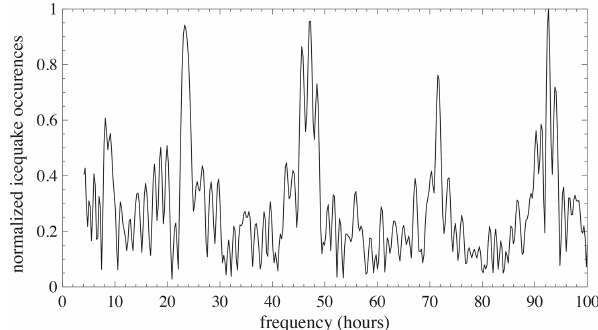
Figure 6. Frequency of icequake occurrences, obtained by discrete Fourier transform of the dates of all icequakes in clusters 0–7 and normalized with the maximum amplitude in the resulting spectrum. The majority of icequakes occur within a period of 24h and are therefore most likely linked to tidal